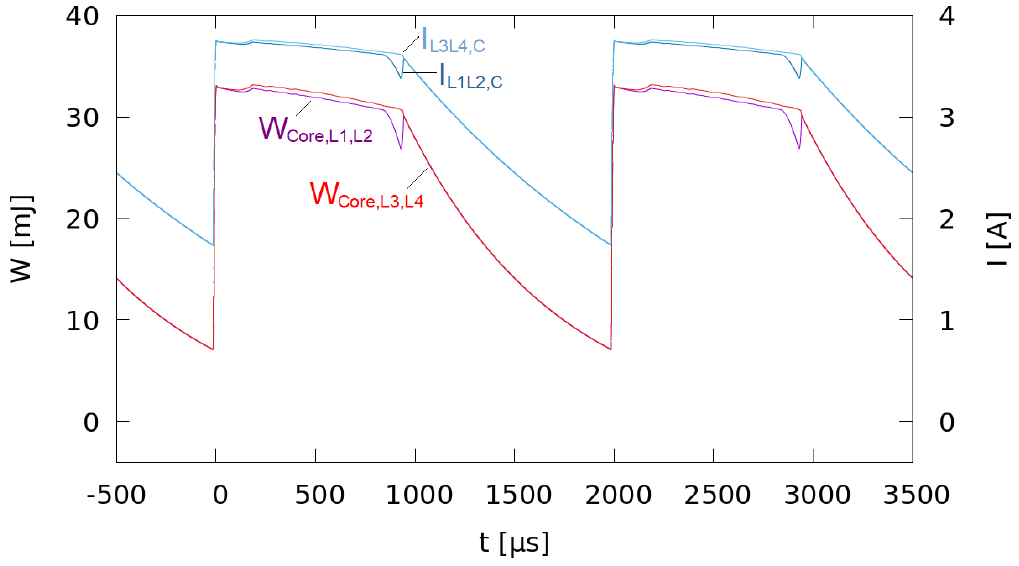
Appl. Sci. 2022 , 12 , x FOR PEER REVIEW Figure 15. Energy stored in the cores of two current-compensated chokes (W Core ) and common-mode